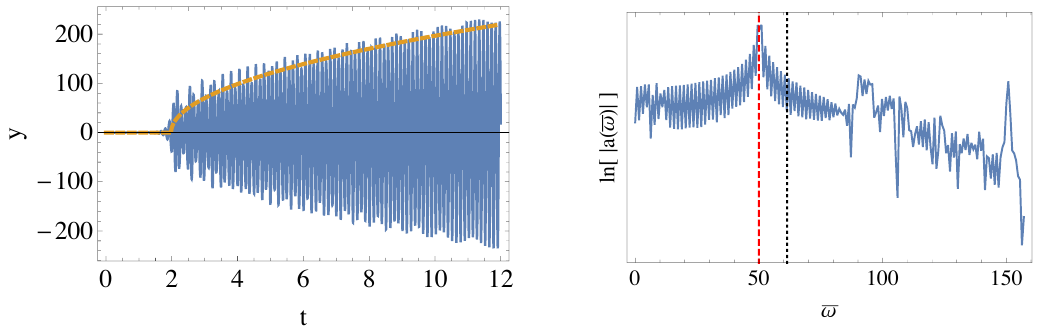
Figure 1 . A solution to eq. (4.6) with the parameters given in (4.8). Left: the solid blue line shows the numerical solution and the dashed orange line shows the amplitude obtained with eq. (4.17). The solution represents the evolution of the Higgs (cid:12)eld in a simpli(cid:12)ed treatment. Right: the coe(cid:14)cients of the Fourier cosine series, a ((cid:22) ! ), with (cid:22) ! being a frequency of y ( t ). It is calculated for 8 < t < 12. The dashed red line indicates (cid:22) ! = != 2 and the dotted black line indicates (cid:22) ! =